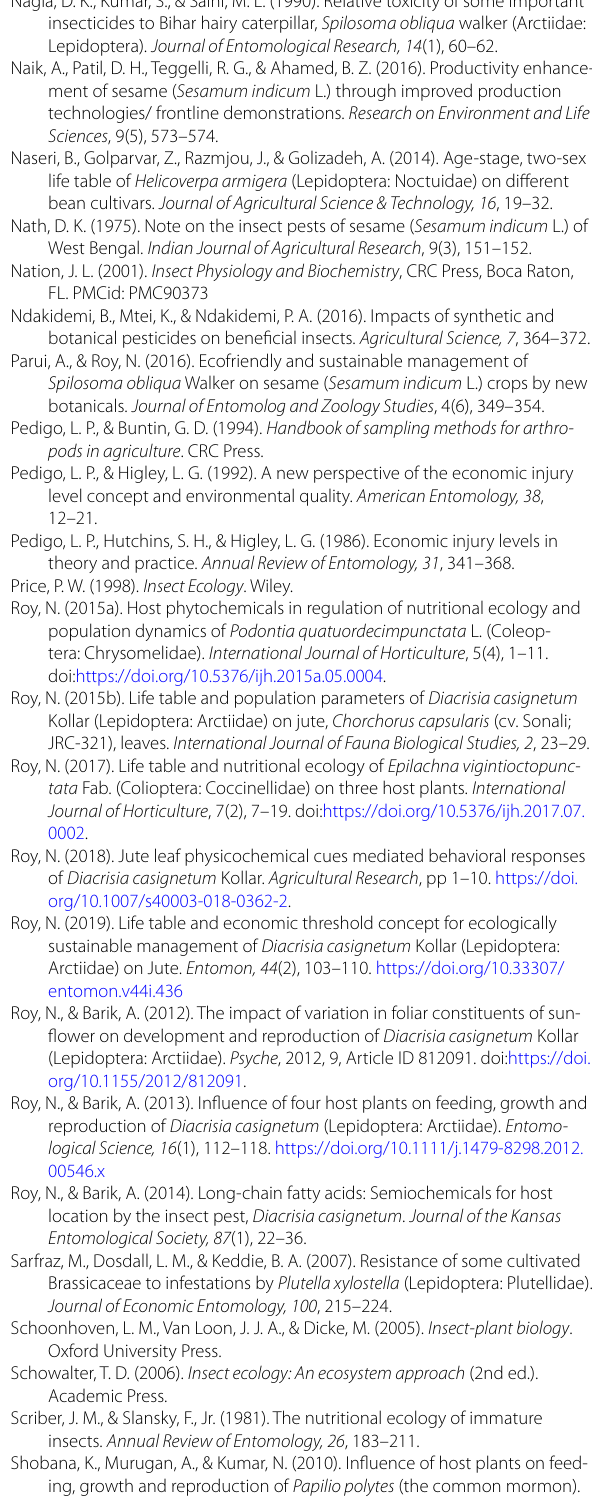
Life table of Spilosoma obliqua (Lepidoptera: Arctiidae) on sunflower. Insect Science and Its Application, 18 ,